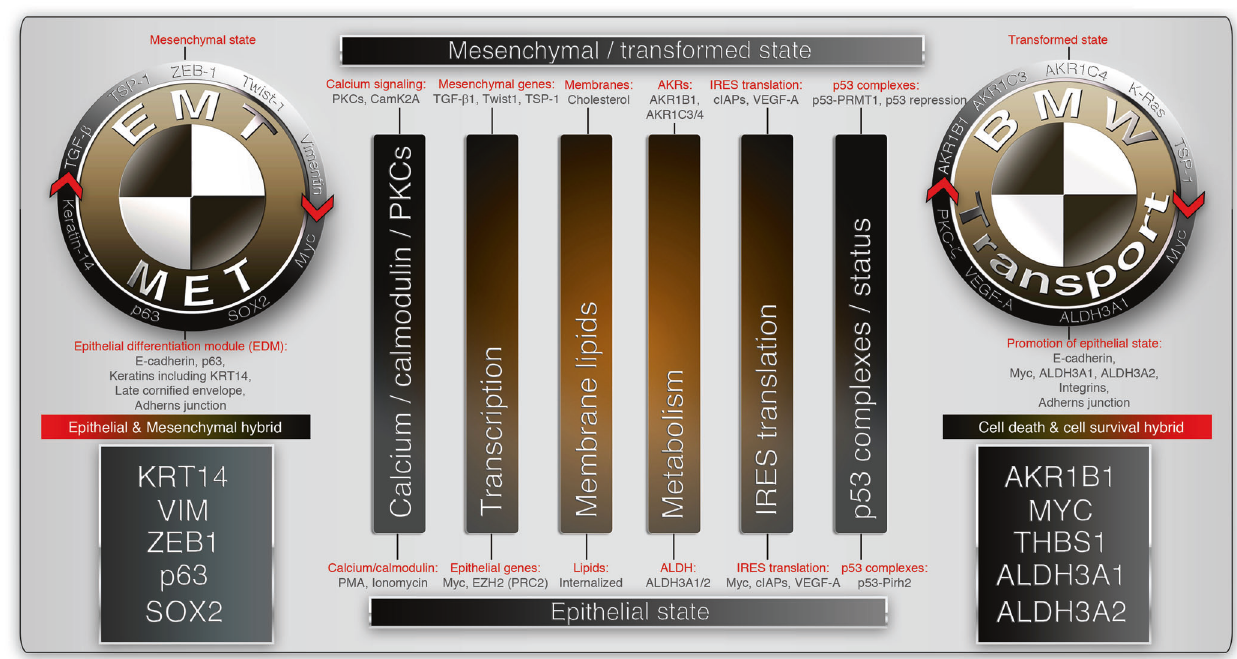
Fig. 5 Similarities between EMT and BMW pathways of metastasis. The non-exhaustive common signatures associated with metastasis in the context of EMT and BMW pathways are represented. The mesenchymal state of the EMT pathway is analogous to the transformed state of the BMW pathway and are executed by similar biological functions but with different tools (Top side of the fi gure). Likewise, the reversible epithelial state of the EMT pathway is analogous to the exit phase of blebbishield emergency program (BMW pathway) and are executed by similar biological functions but with different tools (Bottom side of the fi gure). The main biological functions shared by EMT and BMW pathways are represented by vertical bars. The key molecules involved in reversible/hybrid-EMT is shown in the black box (far left) and the ones involved in reversible or cell survival and death hybrid is shown in the black box (far right). PKCs protein kinase-C, TSP1 thrombospondin- 1, c-IAPs cellular inhibitors of apoptotic proteins, AKRs aldo-ketoreductases, VEGF-A vascular endothelial growth factor-A, PRMT1